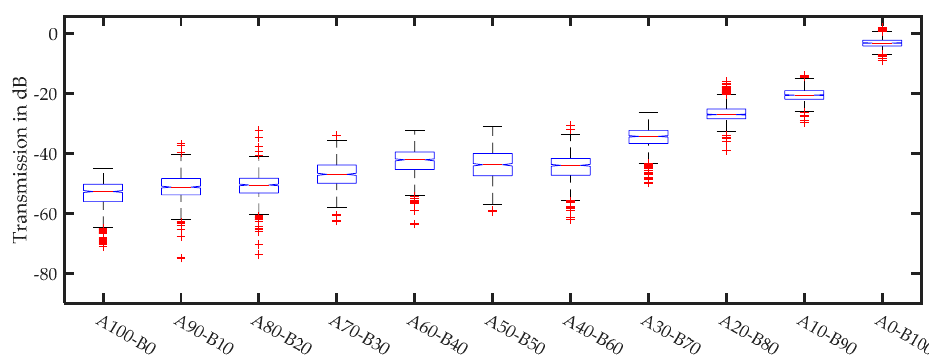
Figure 18. Averaged signal amplitudes for different mixing proportions of fractions A (1.0–1.2 mm) and B (100–210 µm). Averaged results of two different sample positions.